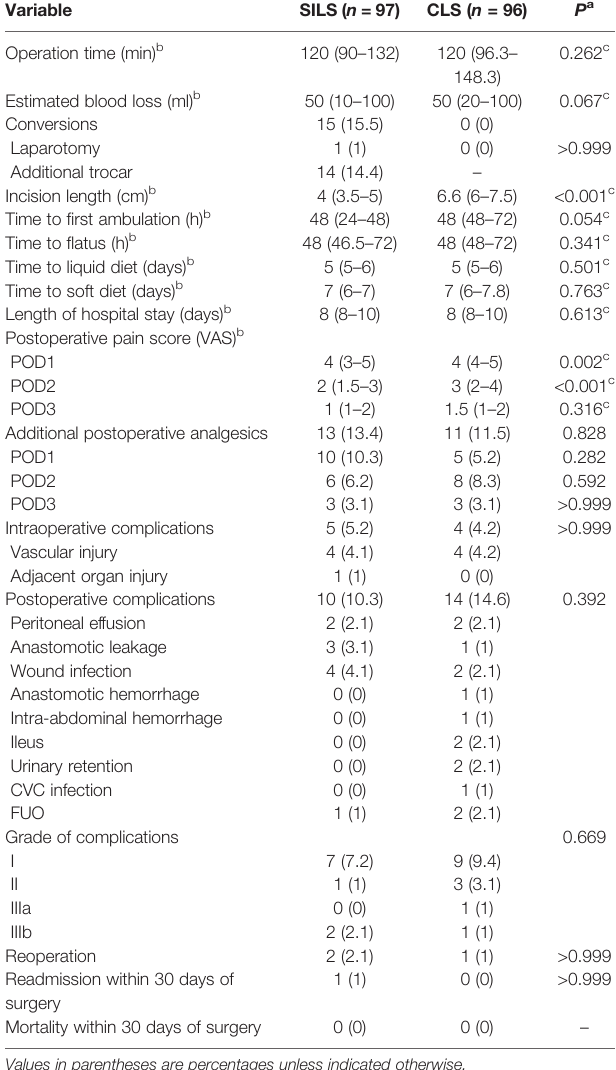
Values in parentheses are percentages unless indicated otherwise. VAS, visual analog score; POD, postoperative day; CVC, central venous catheters; FUO, fever of unknown origin. a c 2 or Fisher ’ s exact test. b Values are median (IQR). c Mann – Whitney U